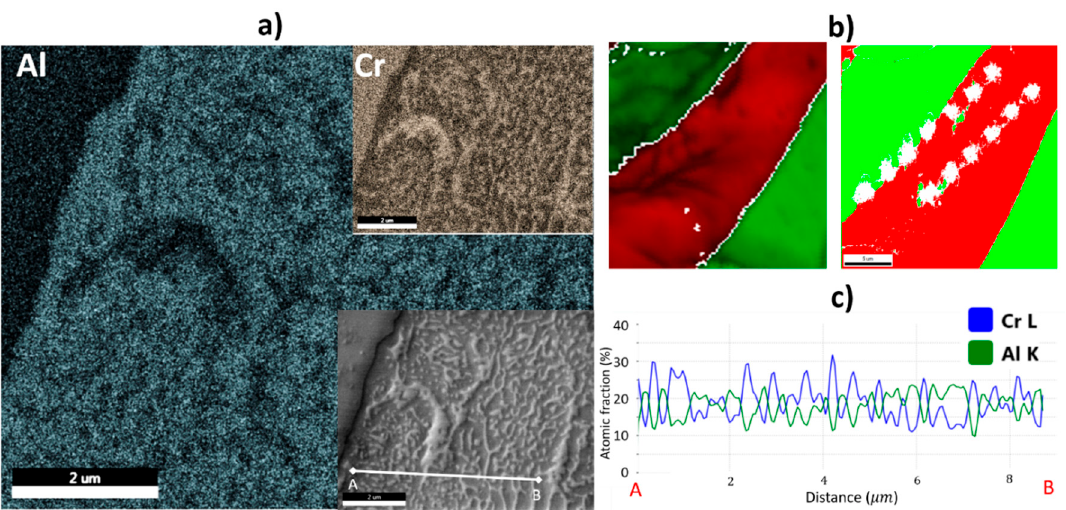
Figure 3. ( a ) EDS maps showing selective partitioning of Al and Cr into B2 and A2 phases, respectively. ( b ) Nano-indentation-induced phase transformation of A2 BCC phase (shown in red) to FCC phase (shown in green). Grain boundaries shown in white in the left image, and the non-indexed areas that are shown in white in the right image correspond to the experimentally made indents; local compositional fluctuations of Al and Cr indicated in ( c ), highlighting the instability of A2 BCC phases in regions of depleted Al, whereby such dynamic phase transformation to FCC at room temperature deformation is facilitated. Experimental data for the figures were derived from [16]. Figure 3b was adapted from [16] with permission from Elsevier, 2018.